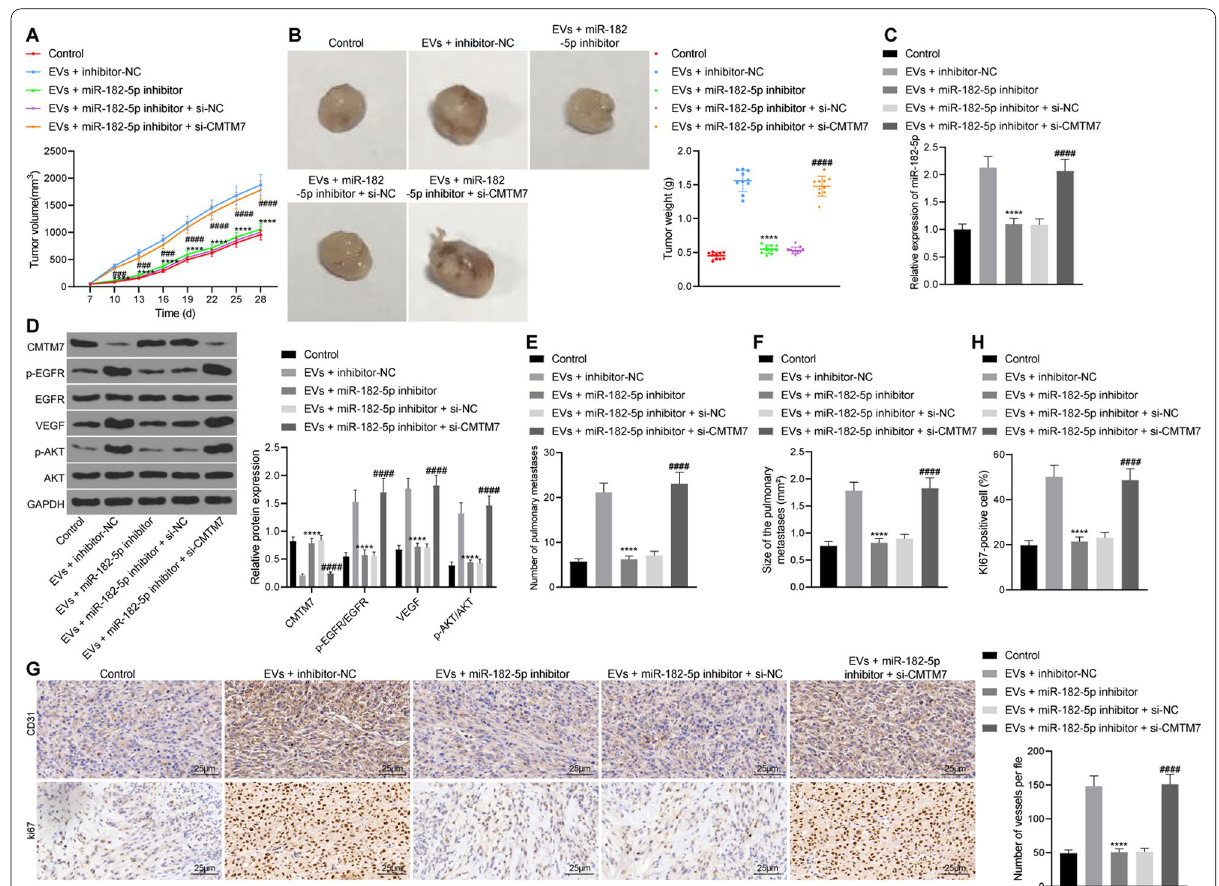
Fig. 7 EVs-miR-182-5p exerts promoting effect on tumorigenesis and metastasis of breast cancer cells in vivo by the CMTM7/EGFR/AKT axis. Mice were treated with EVs inhibitor NC, EVs miR-182-5p inhibitor, or EVs miR-182-5p inhibitor si-CMTM7. A Tumor volume of nude mice, the + + + + statistical power was 1; B Tumor weight of nude mice after 28 days of modeling, the statistical power was 1; C Expression of miR-182-5p in tumor tissues of nude mice detected by RT-qPCR, the statistical power was 1; D Expression of CMTM7, p-EGFR, EGFR, VEGF, p-AKT and AKT protein in tumor tissues of nude mice detected by Western blot analysis, the statistical power was 1; E – F Number E and size ( F ) of pulmonary metastasis in nude mice, the statistical power was 1; G – H CD31 ( G ) and Ki-67 ( H ) immunohistochemical staining of pulmonary metastasis tissues in nude mice, the statistical power was 1. N 10 for mice following each treatment. **** p < 0.0001 compared with mice treated with EVs inhibitor NC. = + #### p < 0.0001 compared with HUVECs treated with EVs miR-182-5p inhibitor si-NC. The experiment was conducted three times + +